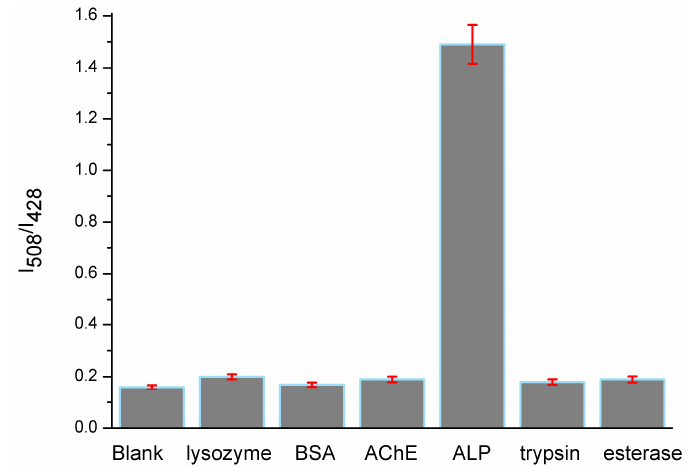
Figure 3. Fluorescent intensity ratio (I 508 /I 428 ) changes of probe 1 in the presence of lysozyme, BSA, AChE, ALP, trypsin and esterase in Tris-HCl buffer (pH 7.4, 10 mM) with 1% DMSO.